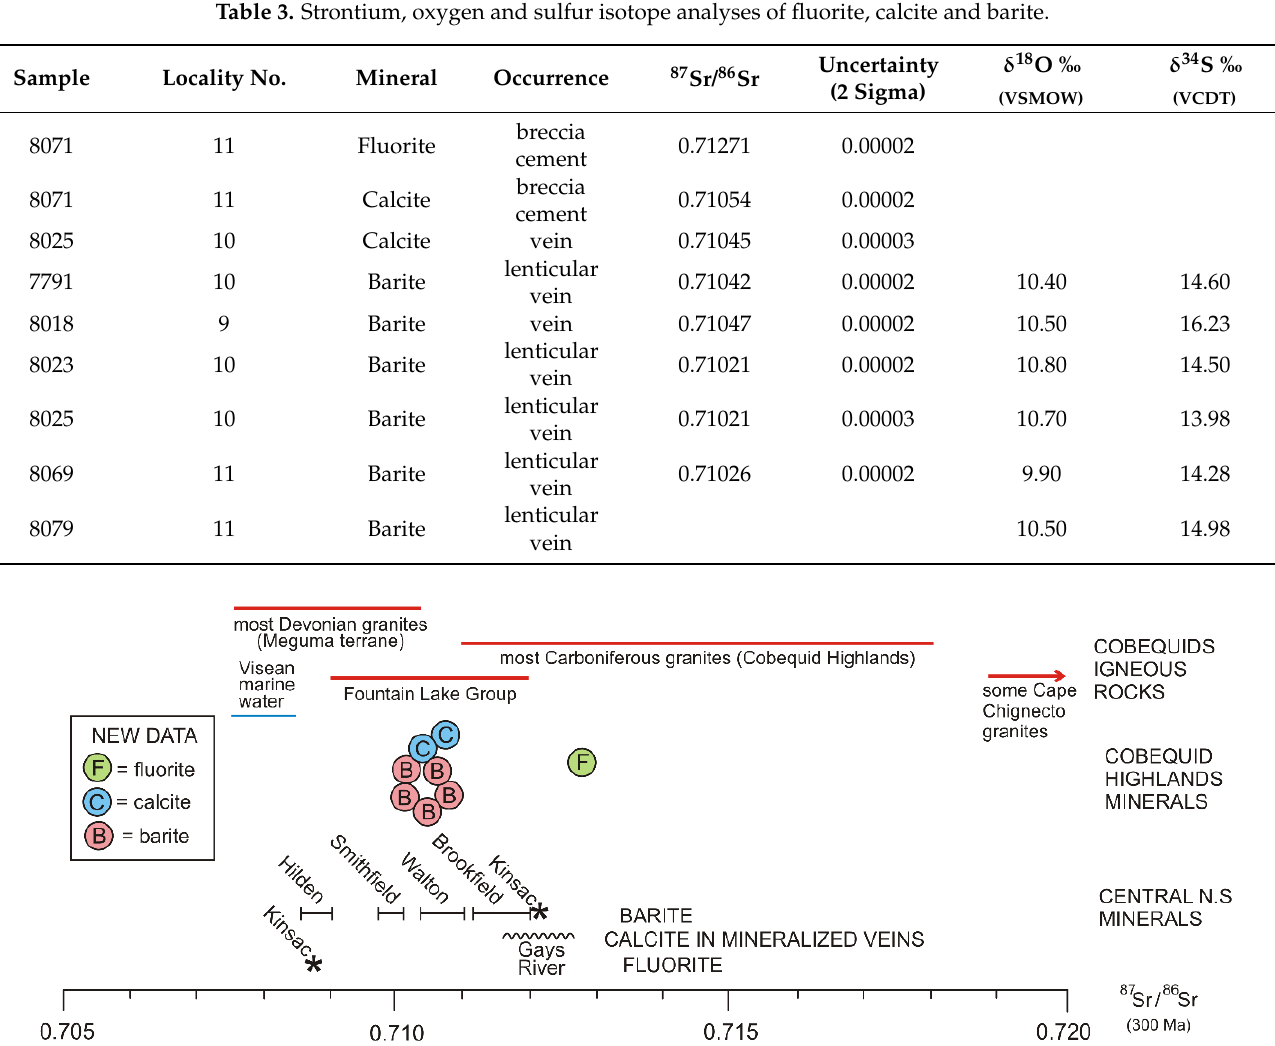
Figure 8. Initial Strontium isotope ratios. Data from Cobequid Highlands from this study; for central Nova Scotia from [7] (excluding outlier values), except [25] for Kinsac; for granites, etc., from [27,28].